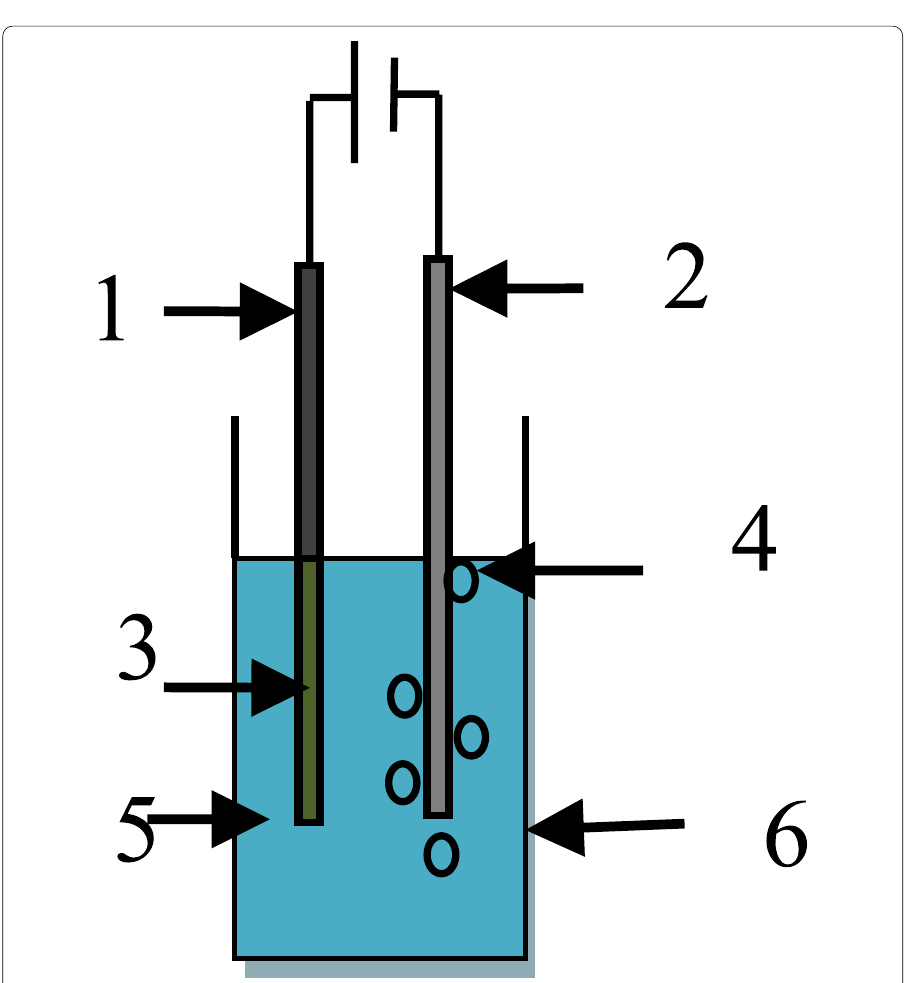
Fig. 2 Schematic representation of the anodizing process: (1) working electrode (anode), (2) counter electrode (cathode), (3) formed alumina film, (4) hydrogenated release, (5) electrolyte, and (6) glass